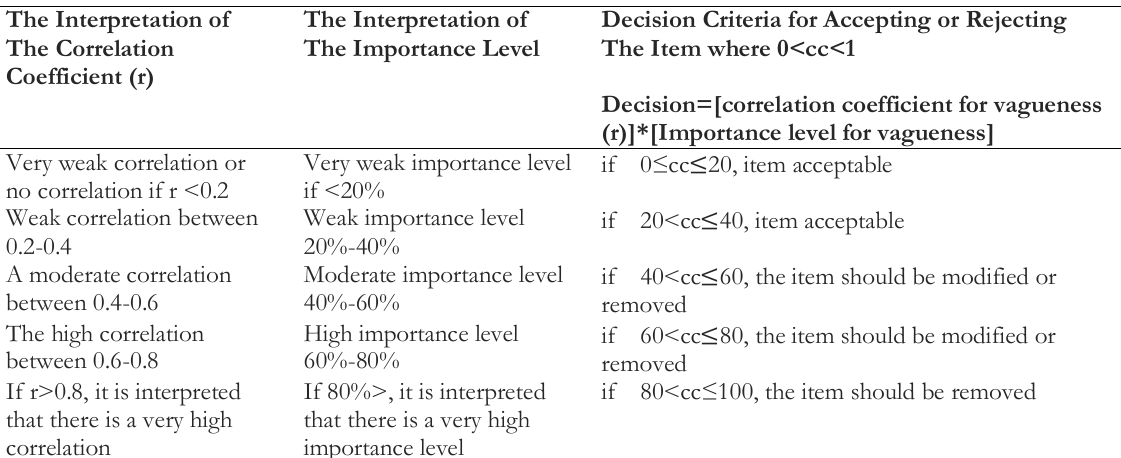
Table 13. The interpretation of the formula